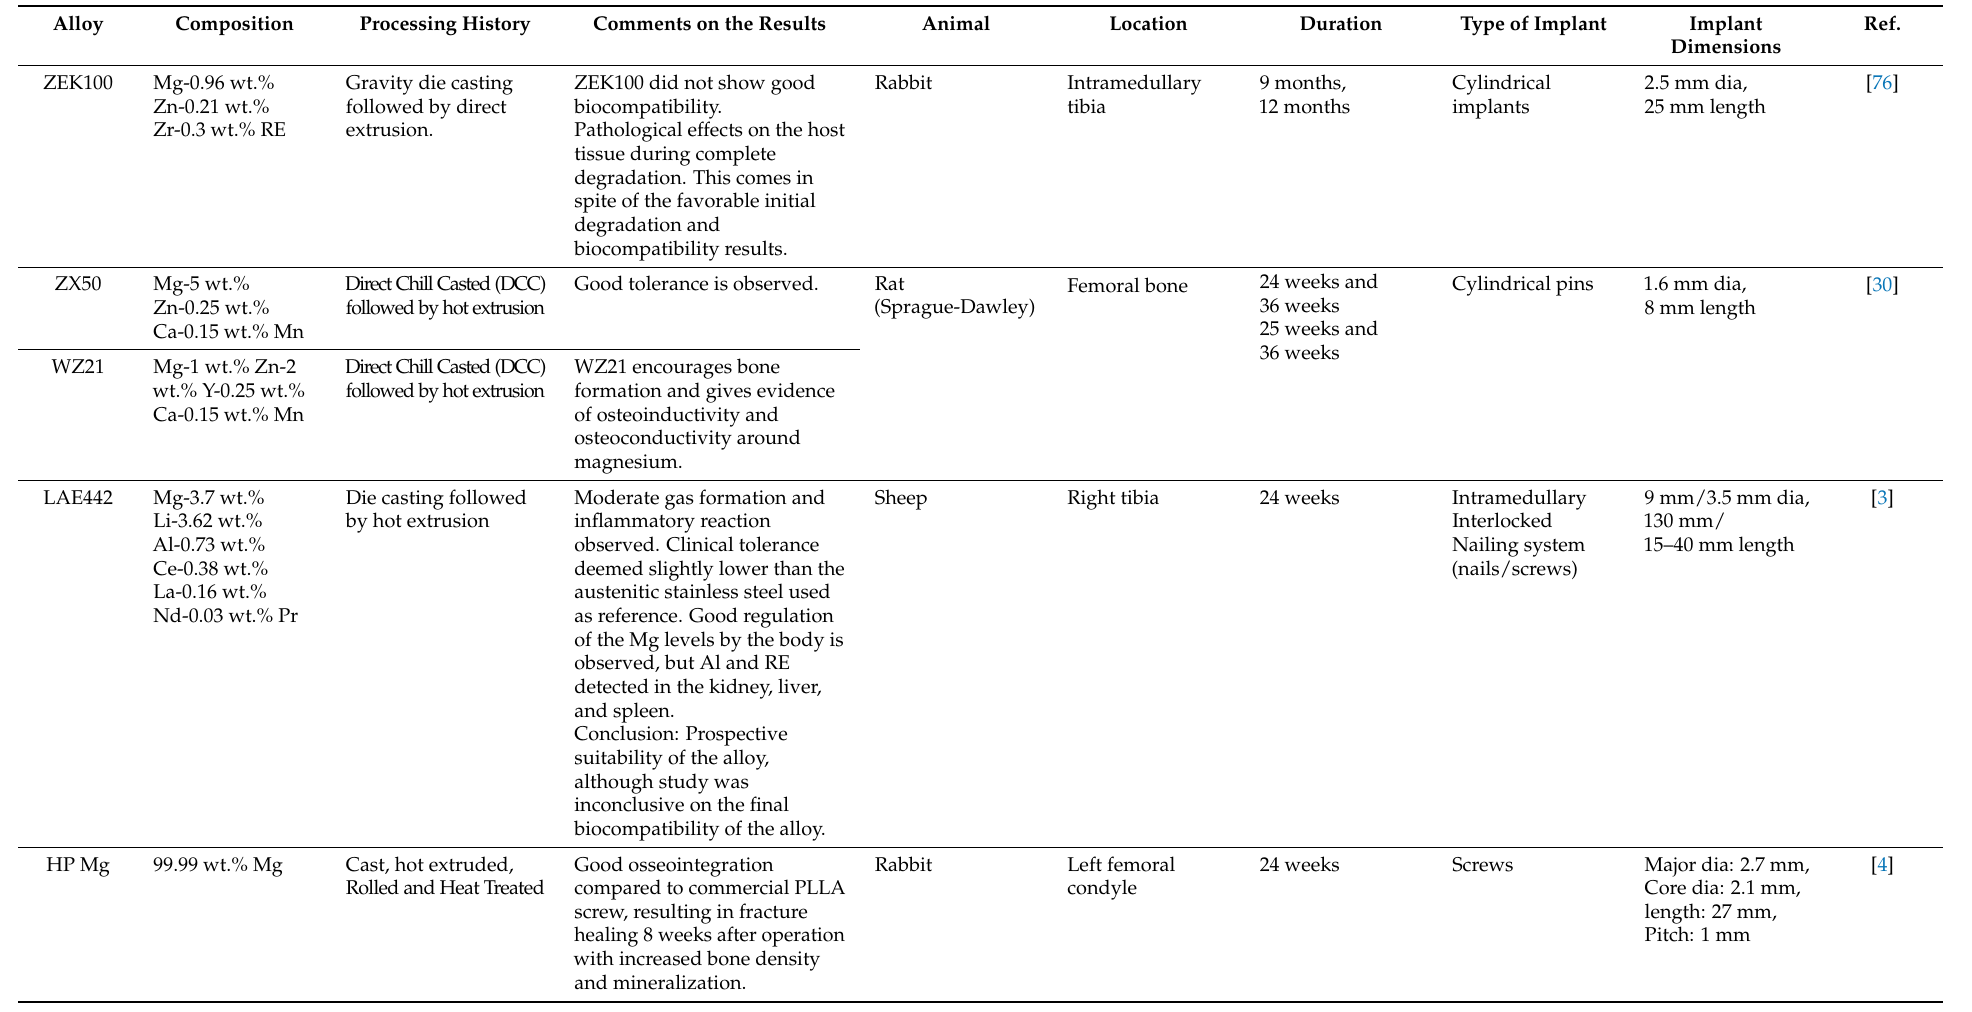
Table 3. In vivo test results for some of the biodegradable alloys as found in